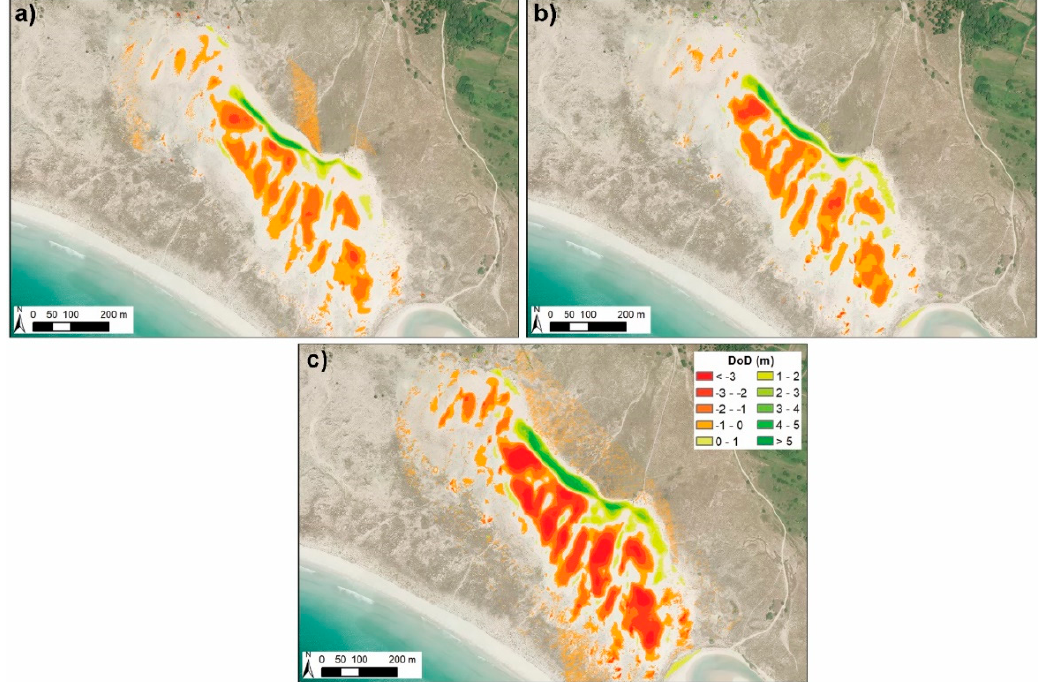
Figure 9. Evolution of surface elevation in large shifting dune sector. ( a ) Difference of Digital Elevation Models (DoD) between 2008 and 2010; ( b ) DoD between 2010 and 2015; and ( c ) DoD between 2008 and 2015.